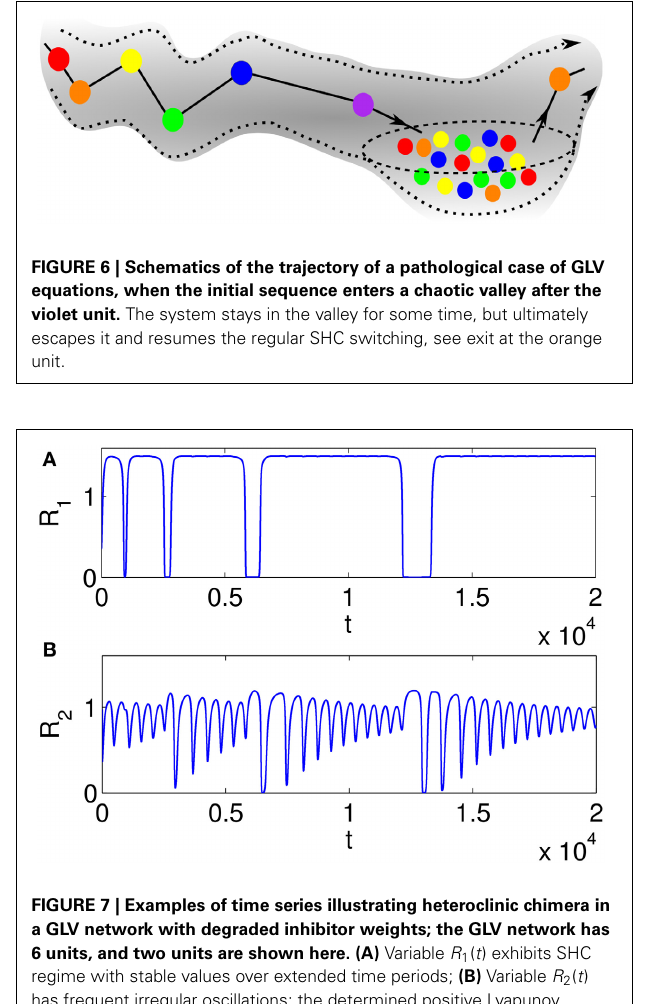
if its amplitude exceeds a threshold value (of 0.1). Note the preser-